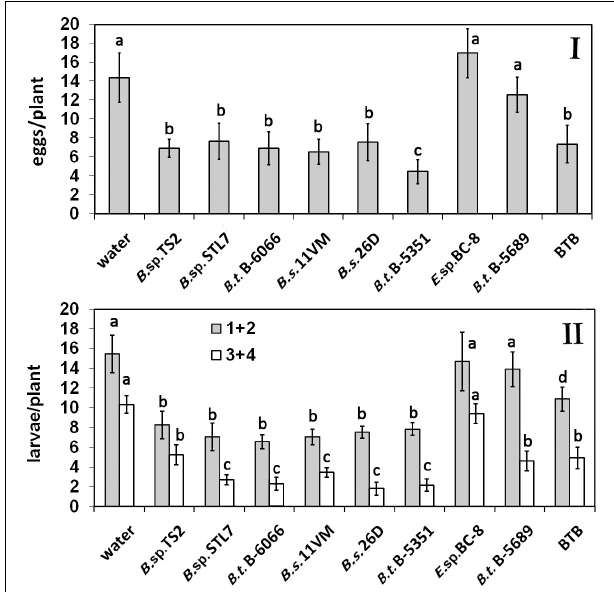
FIGURE 1 | Effect of bacterial agents and Bitoksibacilline (BTB) treatments of potato plants on the total number of eggs (I) and larvae (II) of Colorado potato beetle (CPB) per plant during the whole seasons of 2019 and 2020 (data pooled over the experimental period) (1 + 2, early instar larvae; 3 + 4, last instar larvae). Data represented as mean values ± standard error; values followed by the same alphabet within a column are not significantly different from each other according to Tukey’s honestly significant difference (HSD) multiple-range test at P < 0.05.